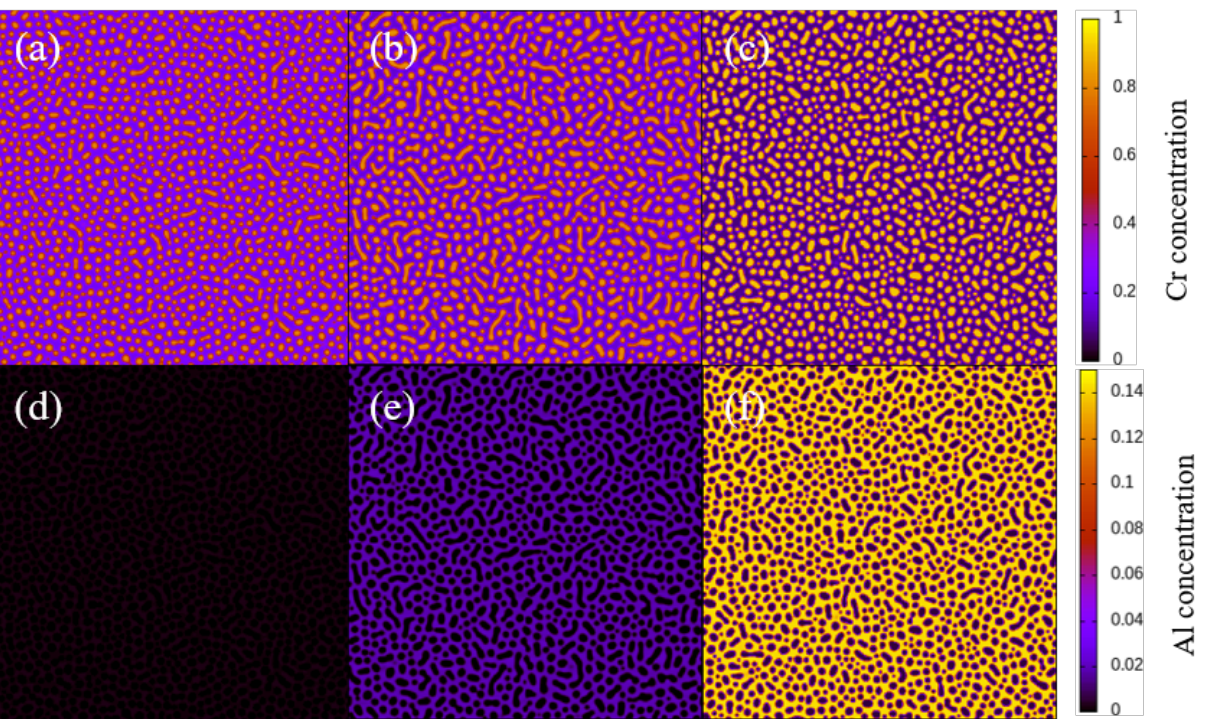
Figure 10. Plots of the Cr or Al concentration at t ∗ = 5.0 × 10 6 when the average Cr concentration was 40% and the average Al concentration was ( a , d ) 0.1%, ( b , e ) 1%, and ( c , f ) 9%. Cases ( a – c ) are plots of the Cr concentration field and cases ( d – f ) are plots of the Al concentration